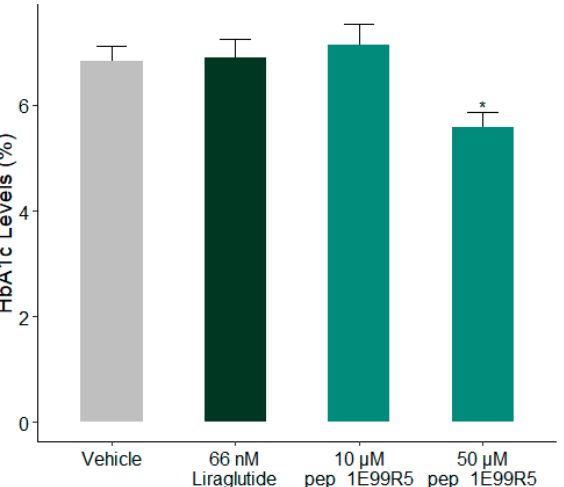
Figure 4. Effect of pep_1E99R5 on HbA1c levels. HbA1c levels (%) of all mice were measured as indicated. Data are mean ± SEM (n = 11 per group; aged 12 weeks at baseline) and analysed by Dunnett’s test to compare the differences between peptide treatment groups, Liraglutide group and vehicle control (* p < 0.05).